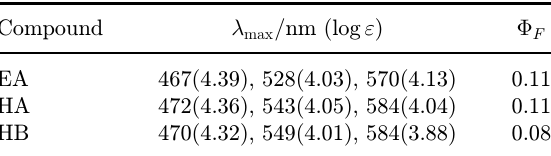
Table 1. The absorption spectra parameters and °uor- escence quantum yield of EA, HA and HB in DMSO